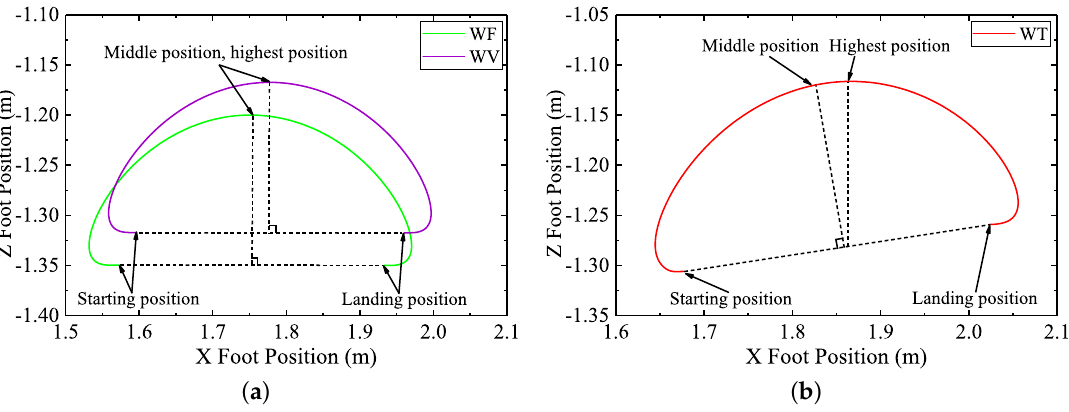
Figure 16. The planned swing trajectories of leg 1 in the robot body coordinate C during one gait cycle: ( a ) the planned swing trajectories of leg 1 with WF and WV employed and ( b ) the planned swing trajectory of leg 1 with WT